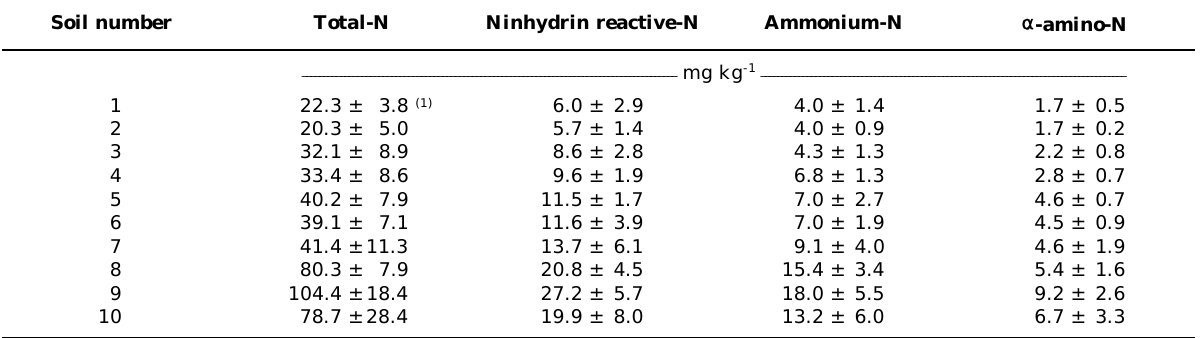
(1) ± Standard deviation.